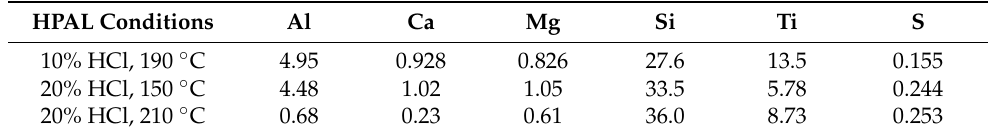
Table 3. Chemical composition of the solid residues obtained by the leaching of the WAT sample at S:L ratio = 1:11 for 60 min (wt.%).